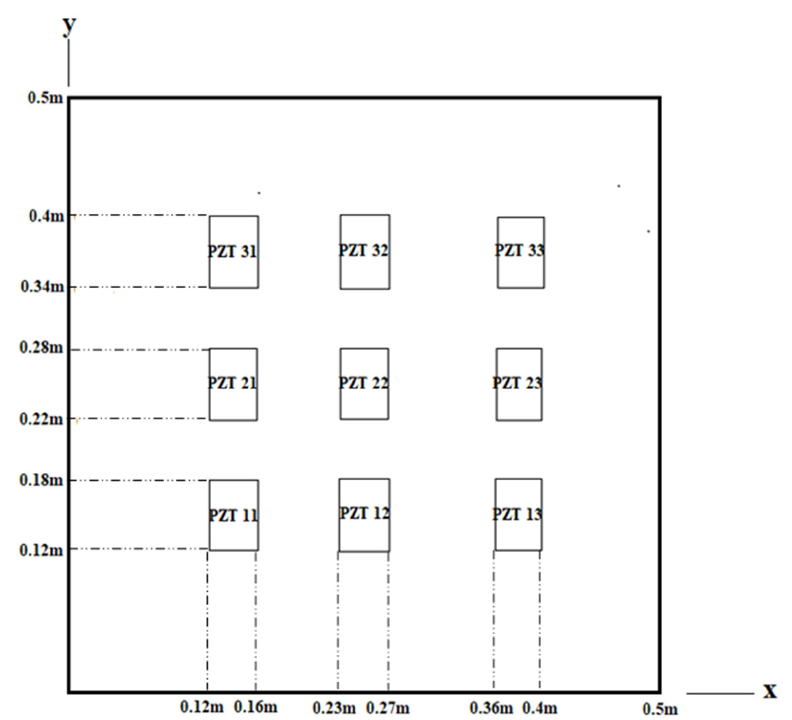
Figure 10. Periodic PZT 3 × 3 array on the composite laminate plate.